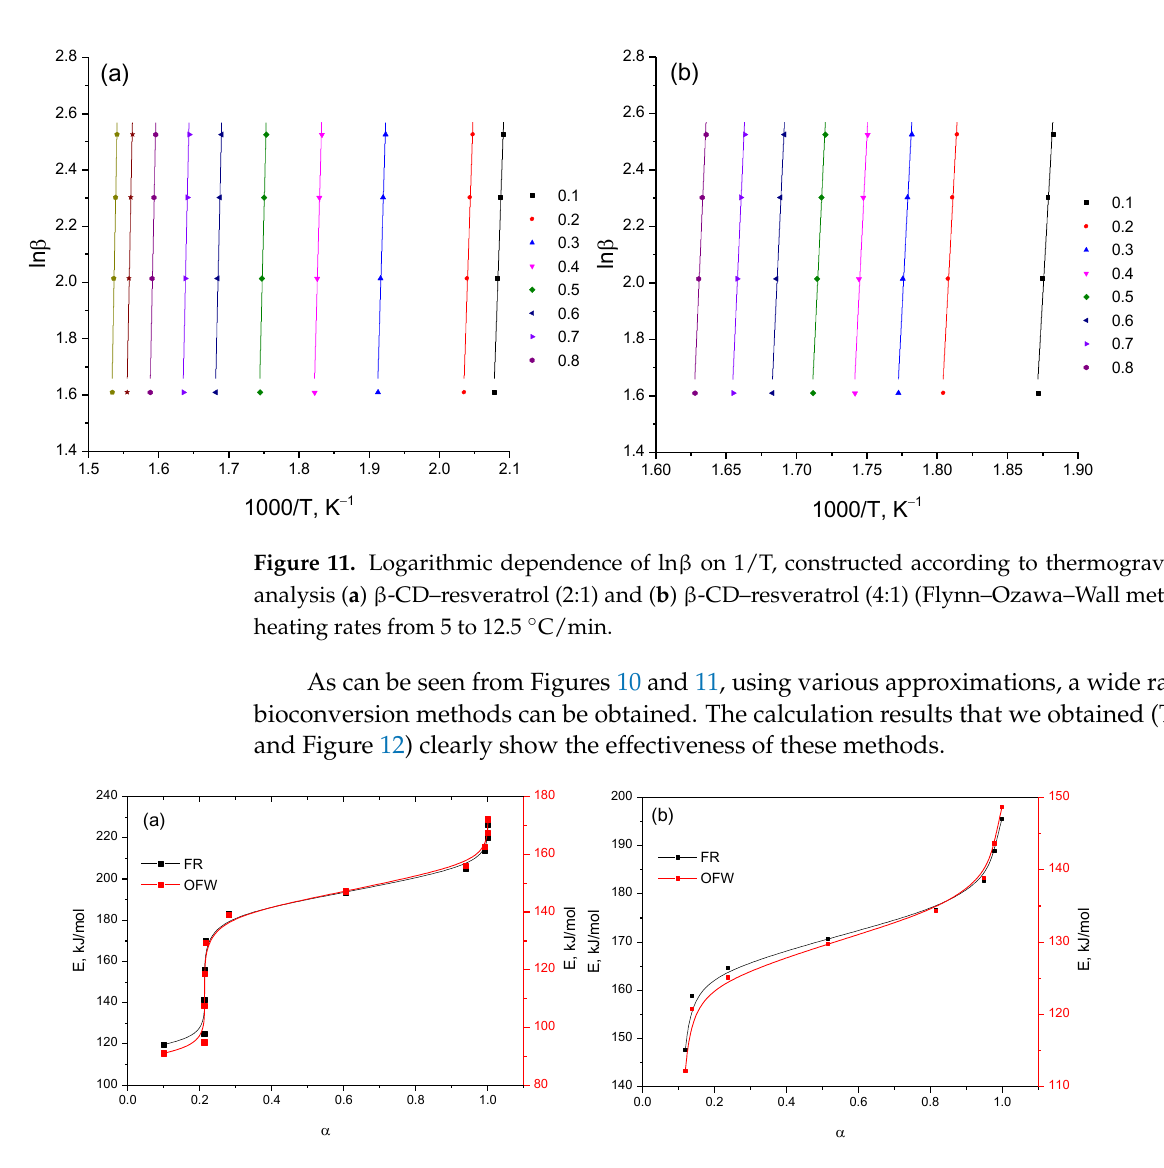
metric analysis: ( a ) β -CD – resveratrol (2:1) and ( b ) β -CD – resveratrol (4:1) (Friedman method) at heating rates from 5 to 12.5 °C/min.